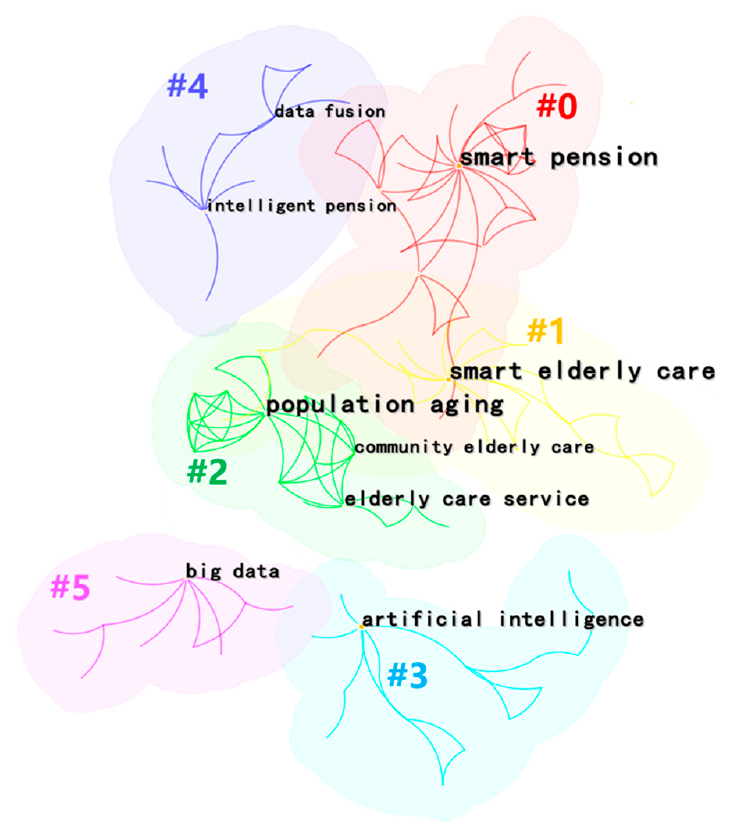
Figure 7. Cluster of co-occurrence terms.